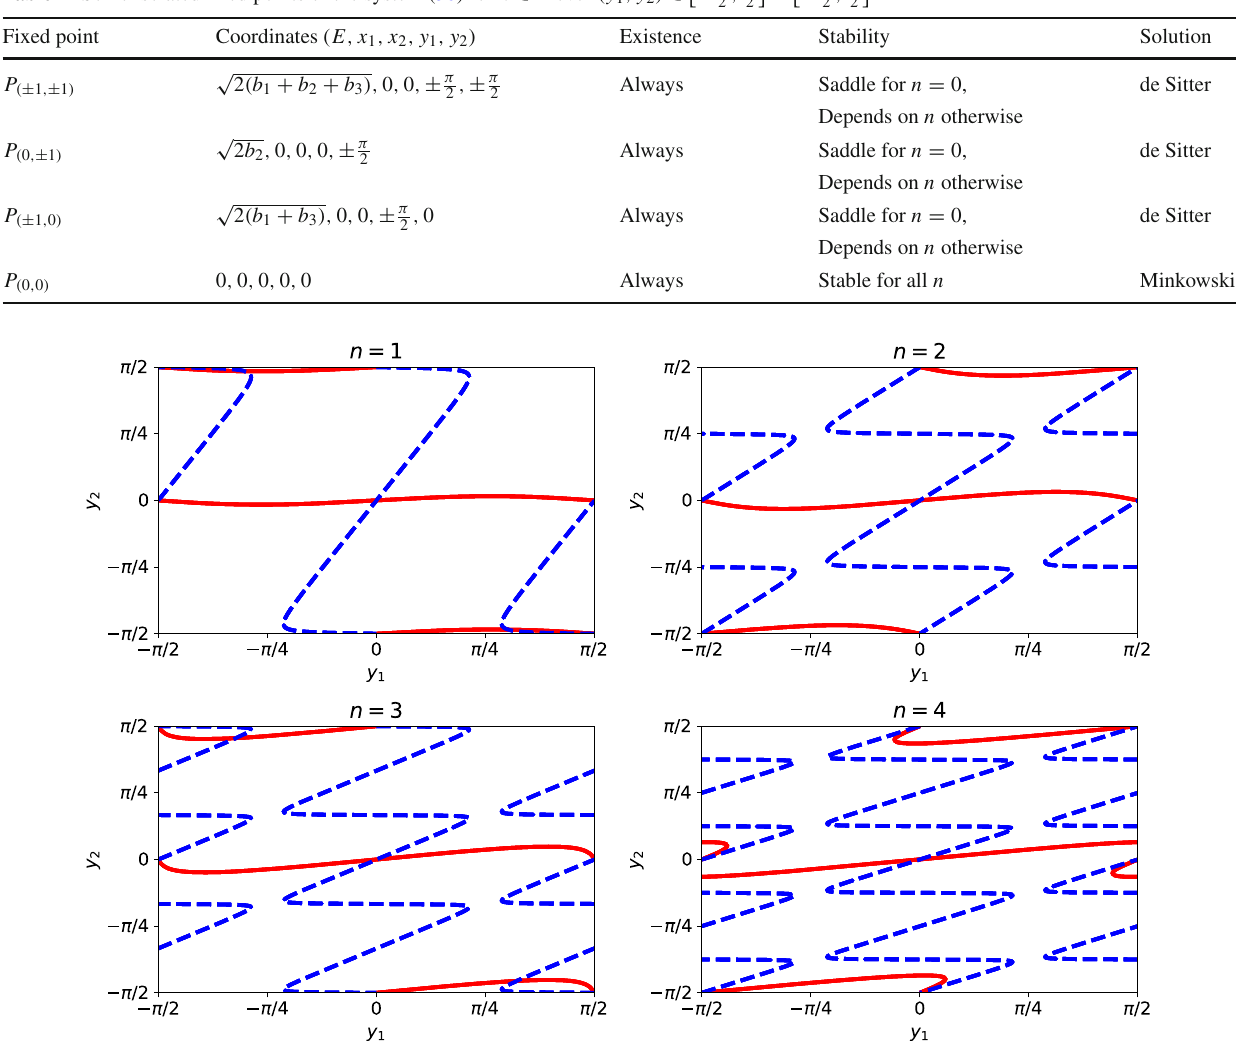
Table 1 Some isolated fixed points of the system (58) for n ∈ Z over ( y 1 , y 2 ) ∈